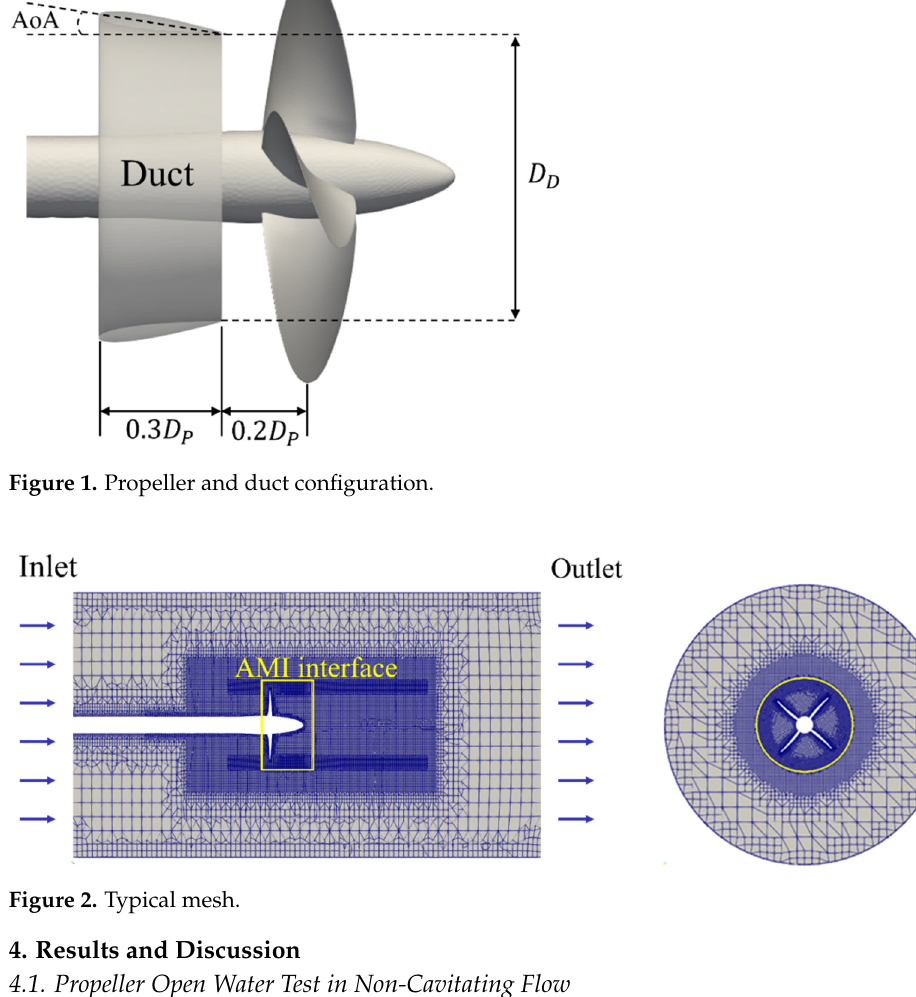
Figure 1. Propeller and duct configuration